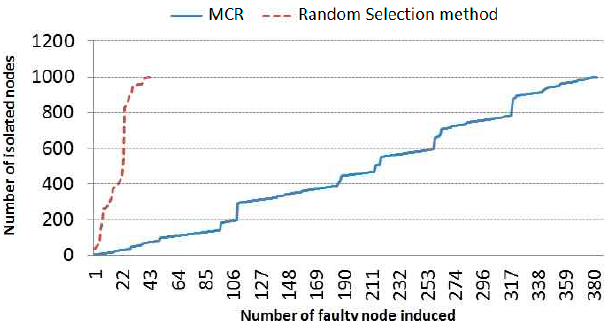
Figure 5. Comparison of the number of isolated nodes for the WSN of 1000 nodes when the number of